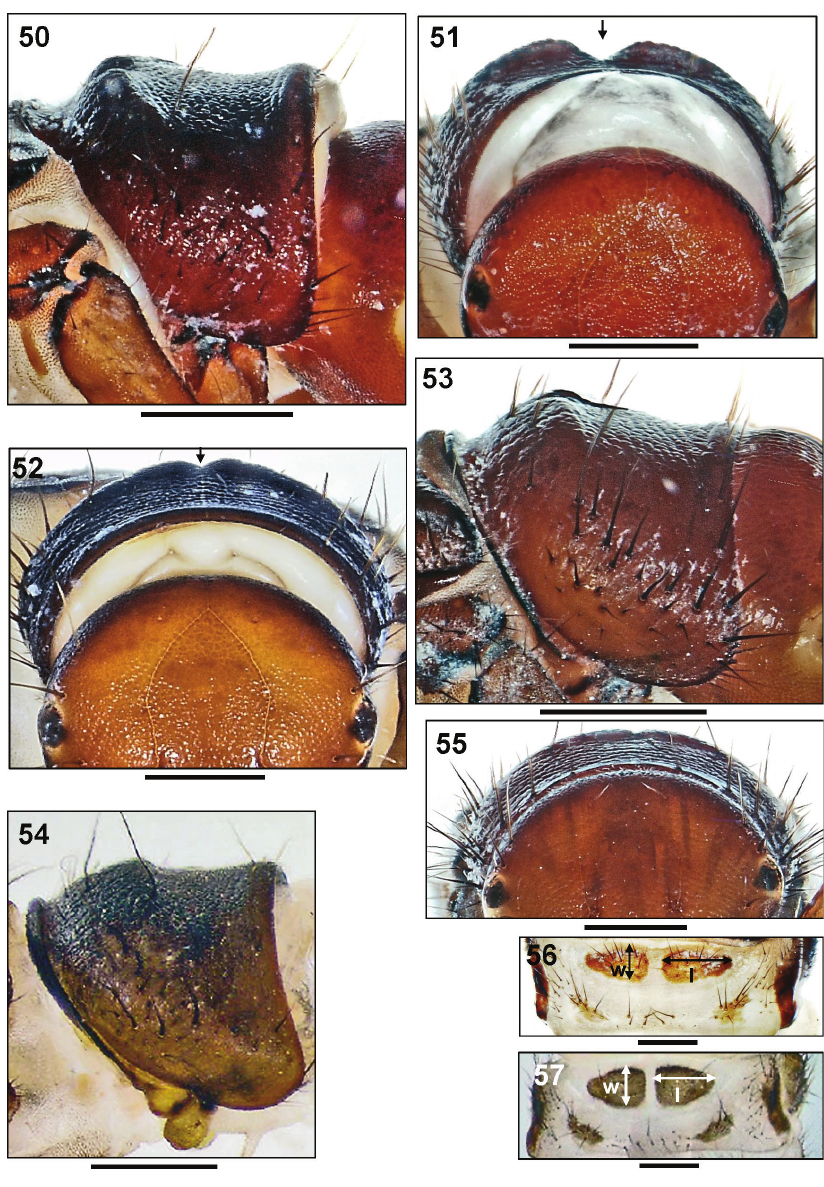
Figures 50–57. 50 Drusus monticola McLachlan, 1876, 5 th instar larva, pronotum, right lateral view. 51–52. Heads and pronota of 5 th instar larvae, frontal views. 51 Drusus ramae Marinkovic-Gospodnetic, 1971 (arrow: deep V-shaped pronotal notch) 52 Drusus monticola McLachlan, 1876 (arrow: shallow V- shaped pronotal notch). 53–54. Heads and pronota of 5 th instar larvae, right lateral views. 53 Ecclisopteryx asterix Malicky, 1979 54 Drusus zivici Kučinić, Previšić, Stojanović & Vitecek, 2017. 55 Ecclisopteryx asterix Malicky, 1979, 5 th instar larva, head and pronotum, frontal view. 56–57. Metanota of 5 th instar lar- vae, dorsal views. 56 Ecclisopteryx asterix Malicky, 1979 (w: width, l: length of anterior metanotal sclerite) 57 Drusus zivici Kučinić, Previšić, Stojanović & Vitecek, 2017 (w: width, l: length of anterior metanotal sclerite). Scale bars: 0.5